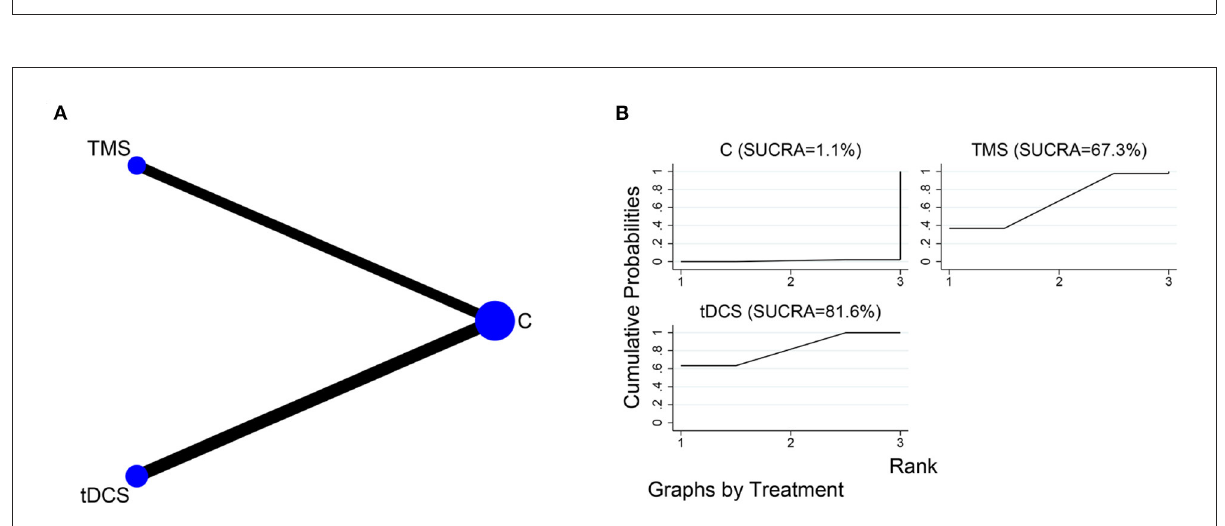
FIGURE7 NMA of MMSE scores at different NIBS. (A) Network plot; (B) SUCRA